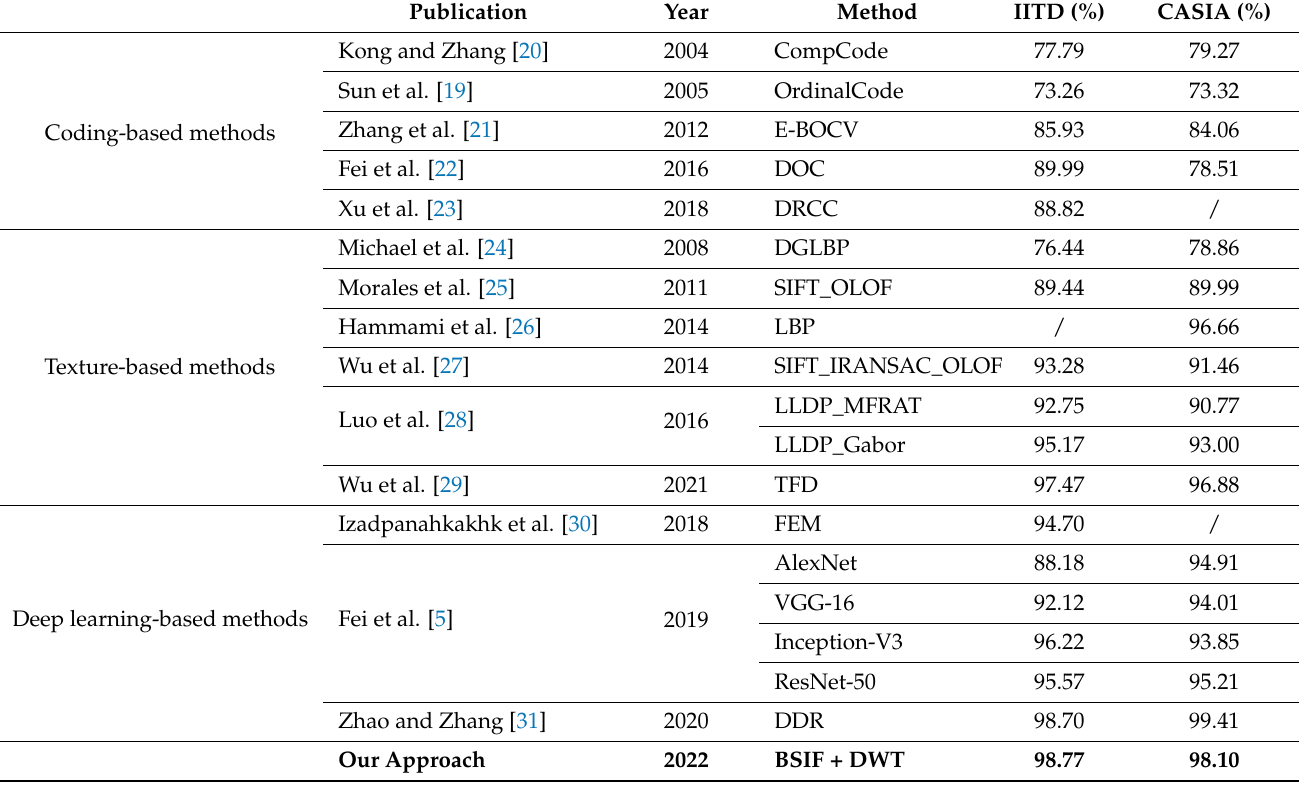
Table 8. Comparison of recognition rates with different recent